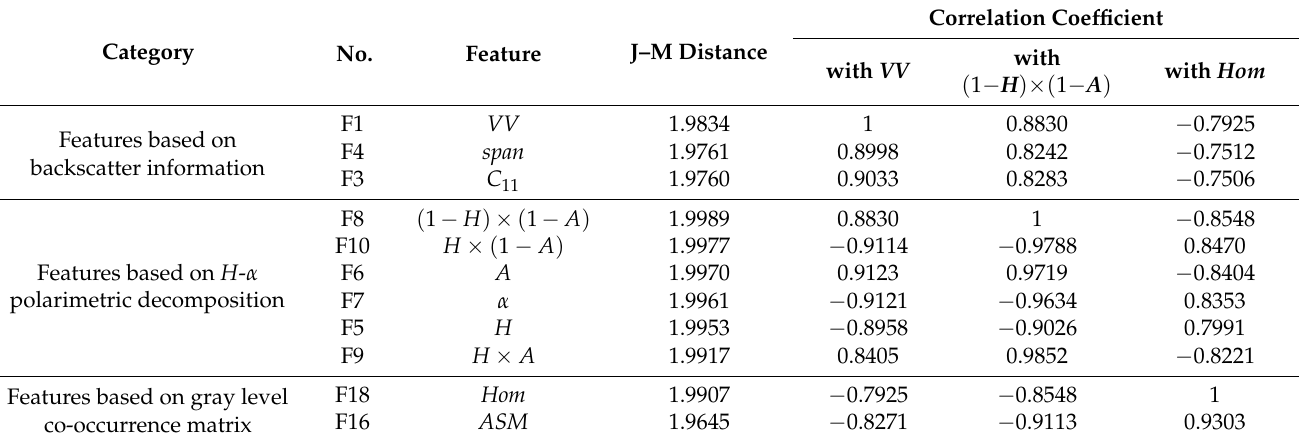
Table 4. Calculation results for the correlation between the dominant features of dual-polarized SAR oil